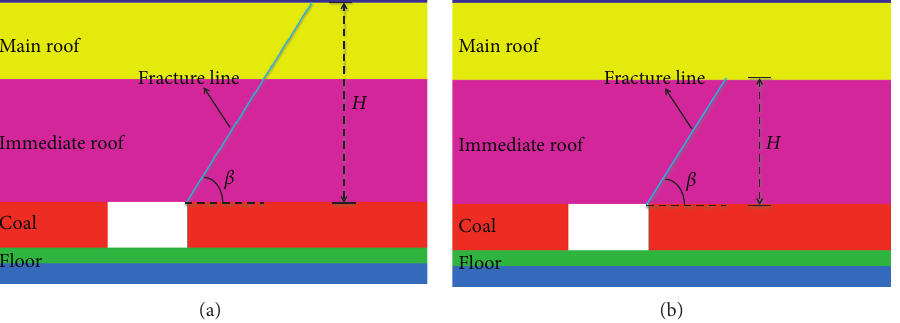
Figure 7: Simulation model.